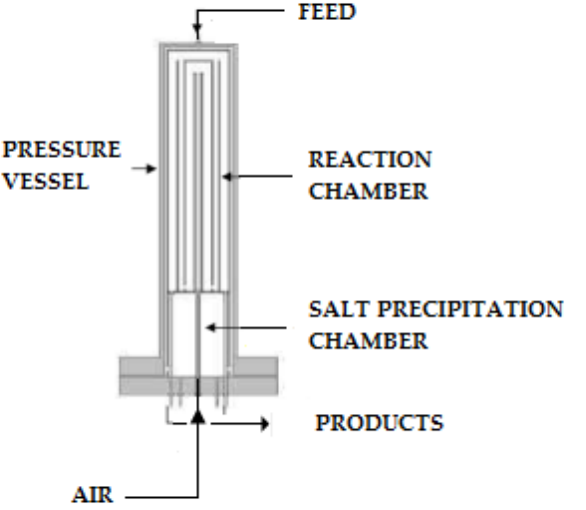
Figure 13. Cooled wall SCWO reactor [52].